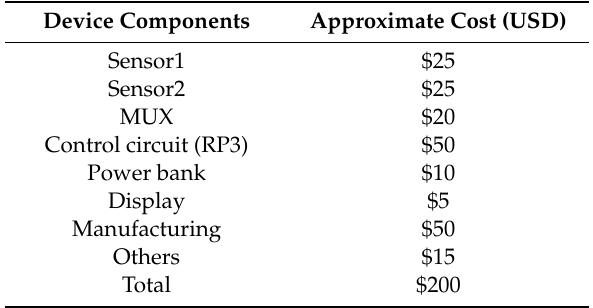
Table 4. Cost of the components of the proposed system. USD—United States dollar.